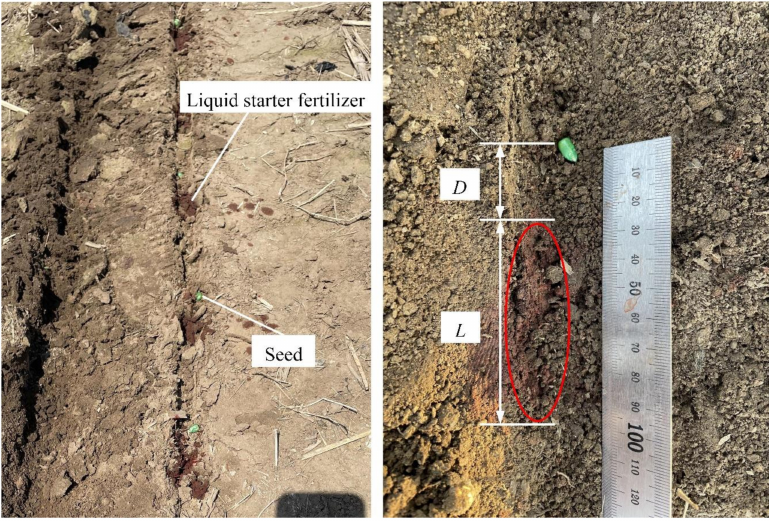
Figure 8. The distribution of seeds and the liquid starter fertilizer in the field